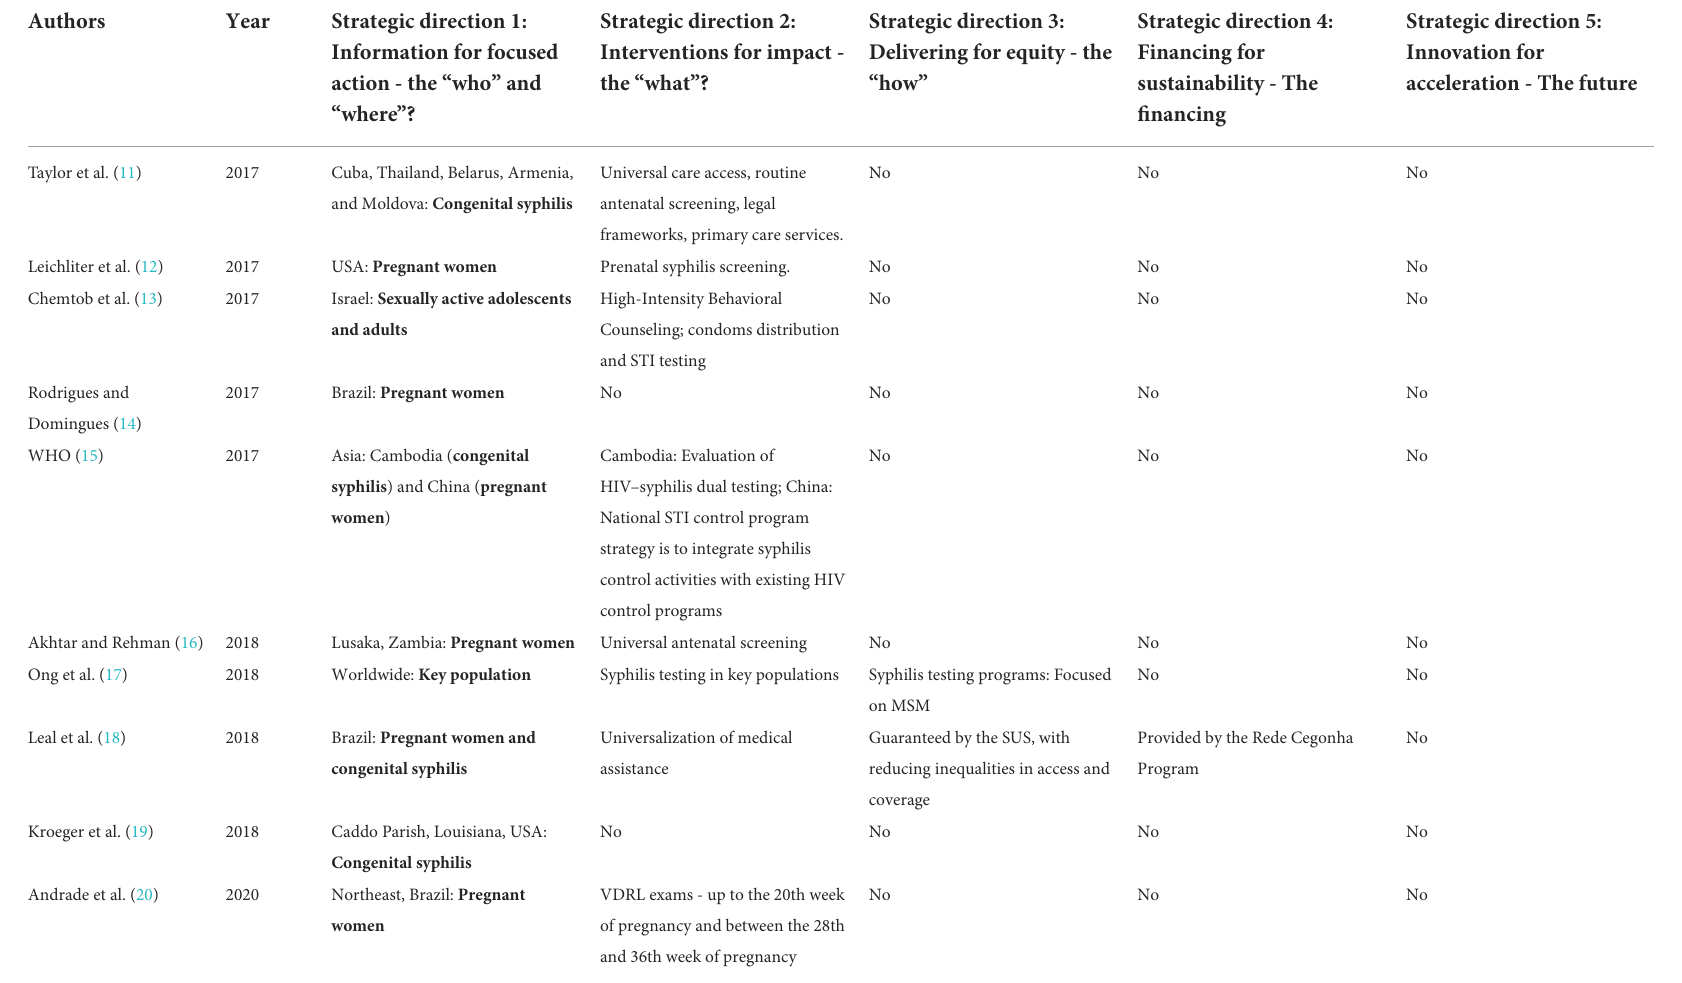
TABLE 1 Strategies implemented according to the WHO 2016